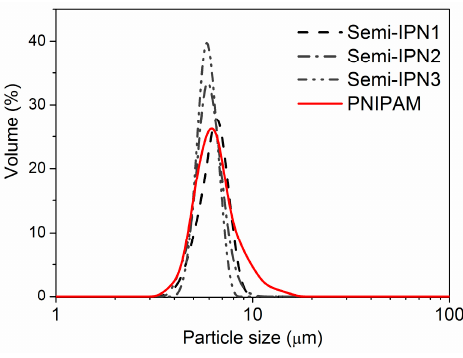
Figure 6. Particle size distribution of the semi-IPN and PNIPAM microspheres (10 mM, pH 7.0 PBS, 25 °C). Table 2. Particle sizes and Span values of the different microspheres (10 mM, pH 7.0 PBS, 25 °C).